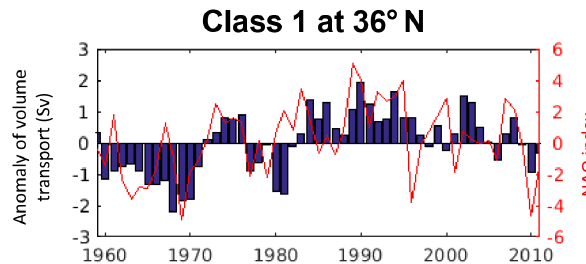
Figure 14. Annual time series of the anomaly of volume transport (Sv, bar plot) compared to the winter NAO index over the period 1959–2011 for Class 1 at 36 ◦ N ( r = 0 . 55, p value = 0.00). Winter NAO index was provided by the Climate Analysis Section (Hur- rell and NCAR, https://climatedataguide.ucar.edu/climate-data/ hurrell-north-atlantic-oscillation-nao-index-station-based, last ac- cess: 25 June